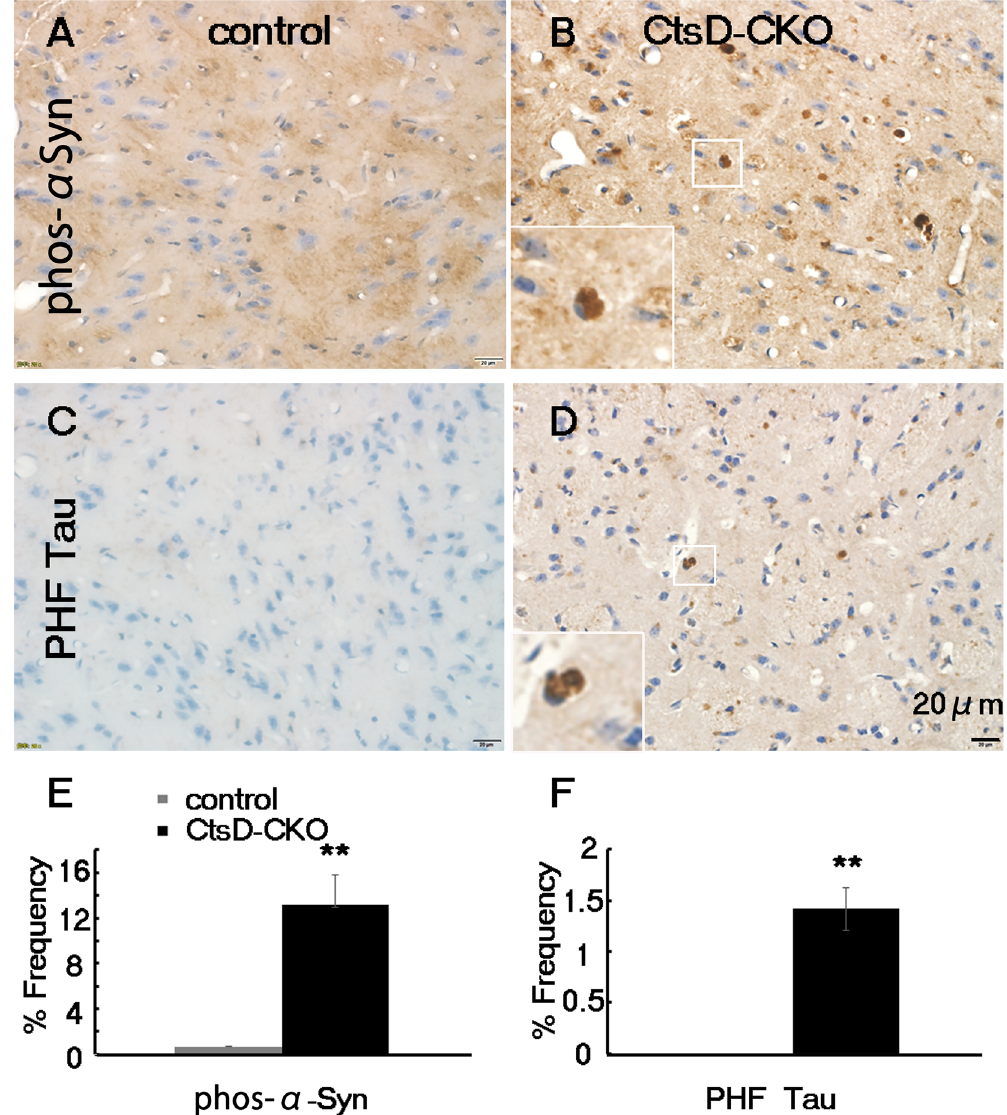
and phosphatase-sensitive epitope on PHF tau ( C , D ) in thalami of CtsD-CKO ( B , D ) and control mice ( A , C ) at p25. Scale bar: 20 µm. The phosphorylated α-synuclein- and PHF tau-positive cells in the thalamus of CtsD- CKO mice and age-matched control littermates were quantified (**p < 0.03; n = 3 sections form separate mice; Over 120 cells per each section were